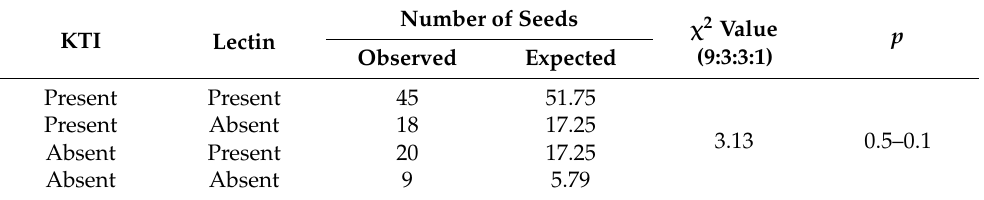
Table 2. Segregation for presence or absence of Kunitz trypsin inhibitor (KTI) and lectin proteins in the F 2 seed generation derived from the cross of the lox1lox2lox3 / lox1lox2lox3 - Ti / Ti - Le / Le - rs2 / rs2 parent and the lox1lox2lox3 / lox1lox2lox3 - ti / ti - le / le - RS2 / RS2 parent. KTI